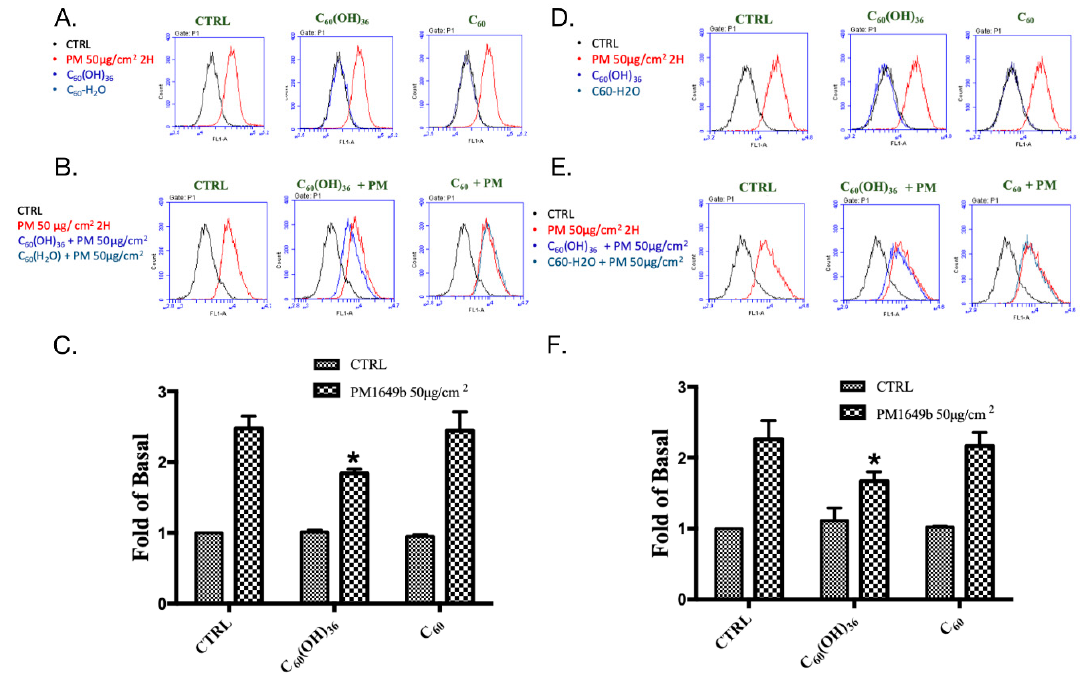
Figure 4. Cellular reactive oxygen species (ROS) production after treating HaCaT cells with fullerenol C 60 (OH) 36 , fullerene C 60 , and PM. ( A ) Raw flow cytometry data obtained after H2DCFDA staining of cells treated with fullerenol C 60 (OH) 36 , fullerene C 60 , or PM alone; ( B ) cells were treated with fullerenol C 60 (OH) 36 or fullerene C 60 for 1 h and then administered PM (SRM 1649b, 50 µ g / cm 2 ) for another 2 h. Signals were detected via H2DCFDA staining. ( C ) The bar graphs illustrate the cumulative counts of H2DCFDA flow cytometry results. ( D ) Raw flow cytometry data obtained after CellROX staining of cells treated with fullerenol C 60 (OH) 36 , fullerene C 60 , or PM alone; ( E ) cells were treated with fullerenol C 60 (OH) 36 or fullerene C 60 for 1 h and then administered PM for another 2 h. Signals were detected